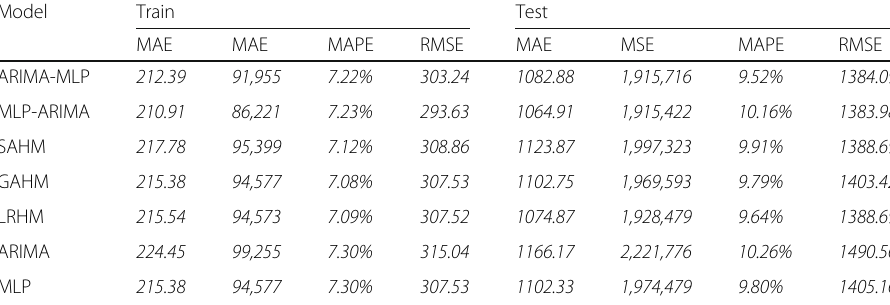
Table 2 Performance of models for SZII using train and test datasets Model